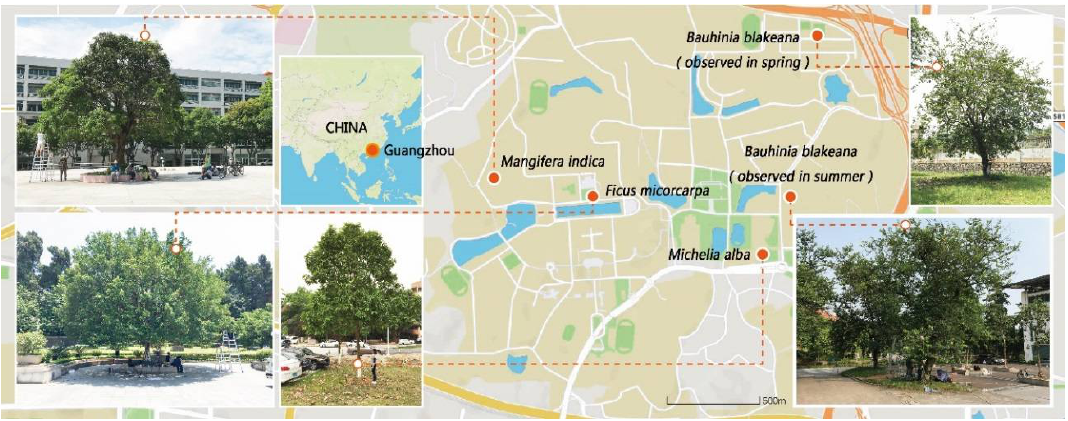
Figure 1. Photographs of the studied trees and the locations of the study sites.